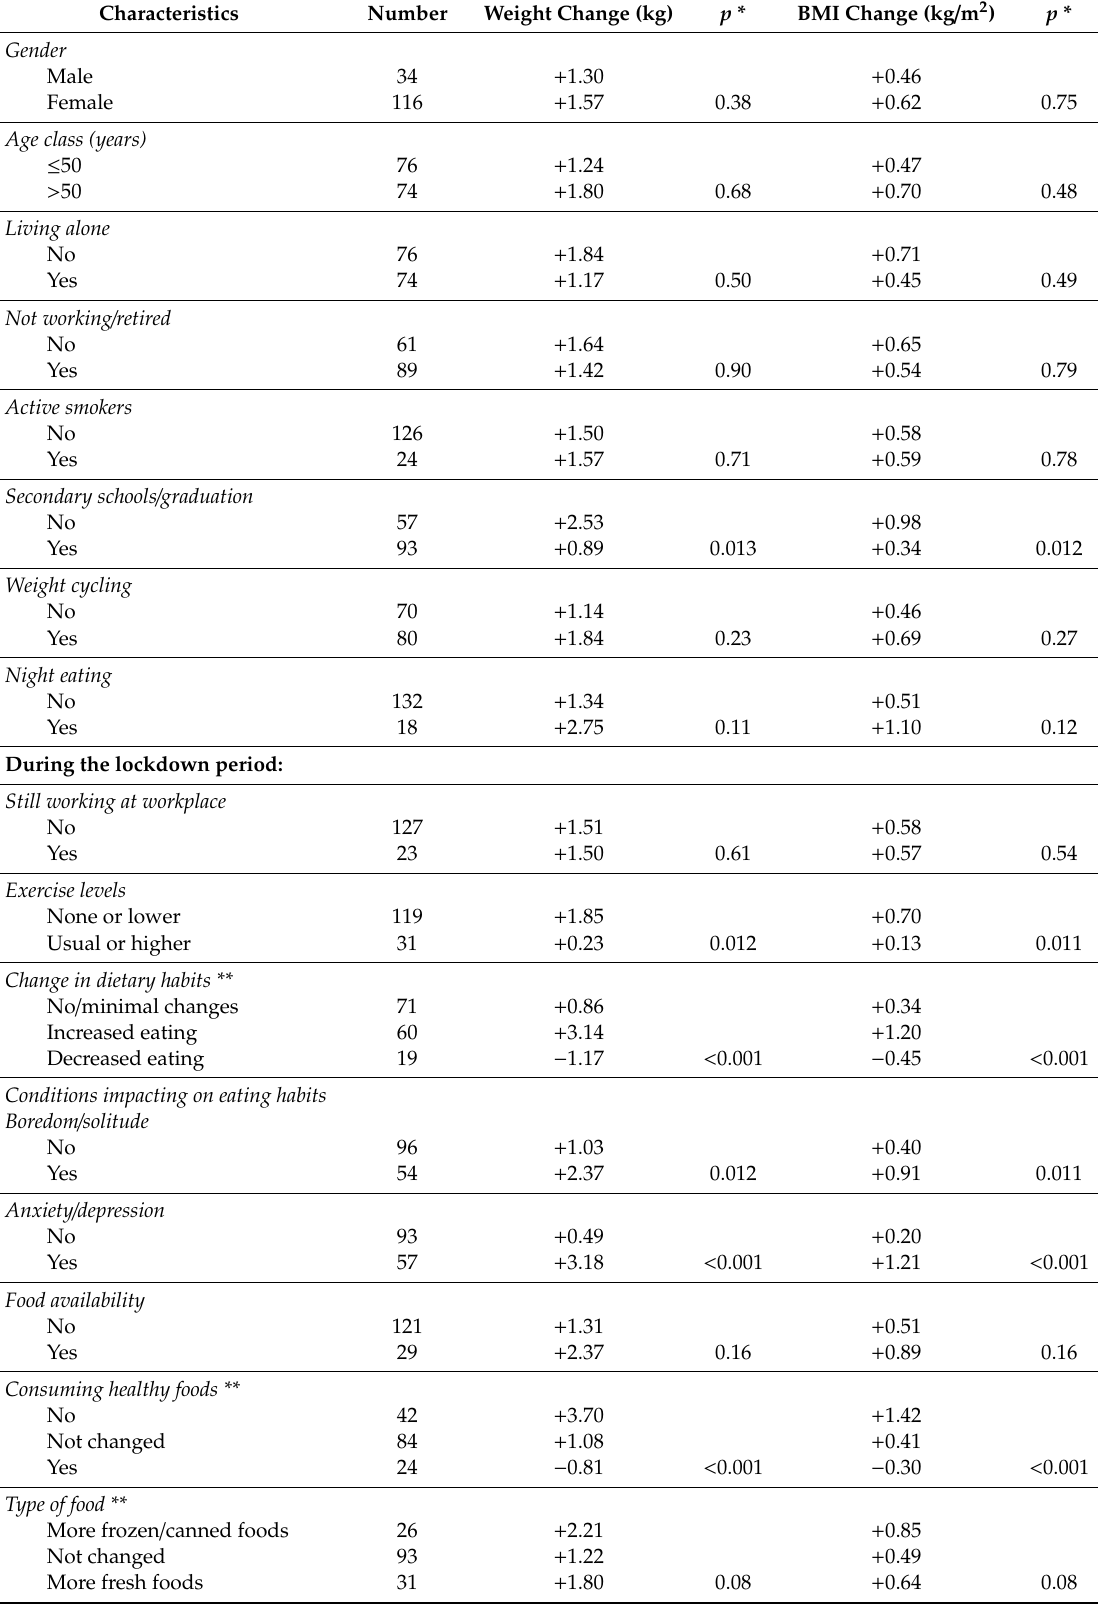
Table 3. Changes in weight and BMI after 1-month lockdown according to di ff erent characteristics.